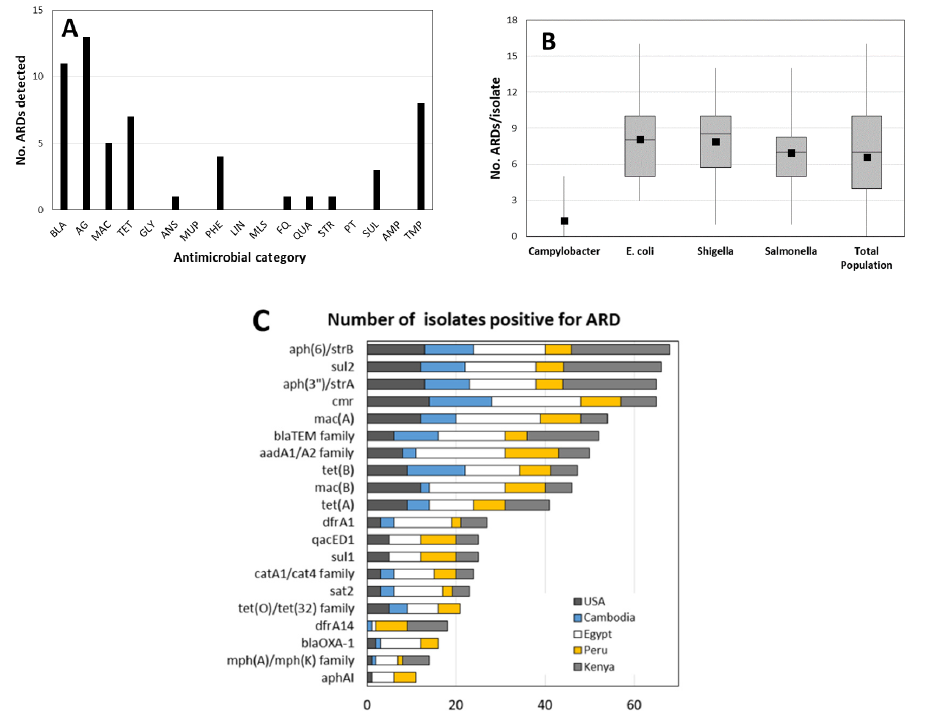
Figure 1. ( A ) Number of antimicrobial resistance determinants (ARDs) detected in tested population, by category; numbers in parentheses indicate total ARDs represented on microarray for that category. BLA = β -lactams (53); AG = aminoglycosides (44); MAC = macrolide (40); TET = tetracyclines (38); GLY = glycopeptides (13); ANS = ansamycins (1); MUP = mupirocin (1); PHE = phenicols (20); LIN = lincosamides (6); MLS = macrolides / lincosamides / streptogramins (13); FQ = fluoroquinolones (4); QUA = quaternary amines (2); STR = streptothricin; PT = platensimycin + platencin (1); SUL = sulfonamides (3); AMP = antimicrobial peptides (1); TMP = diaminopyrimidine. ( B ) Number of ARDs detected per isolate. ( C ) Prevalence of unique ARDs detected in > 10 isolates.